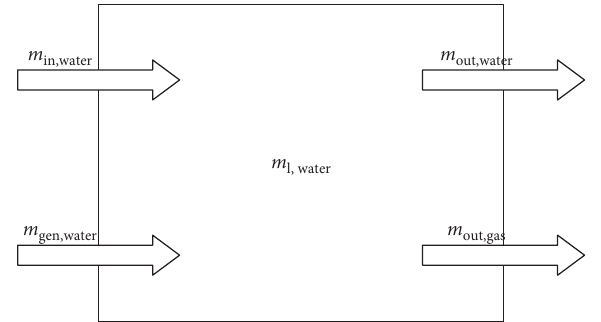
Figure 4: Schematic of the water balance model.